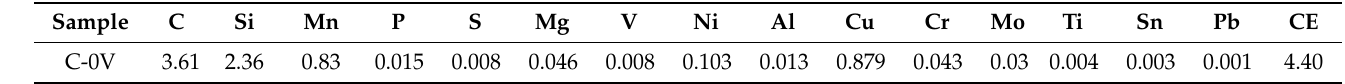
Table 1. Chemical composition of the standard camshaft (wt. %).